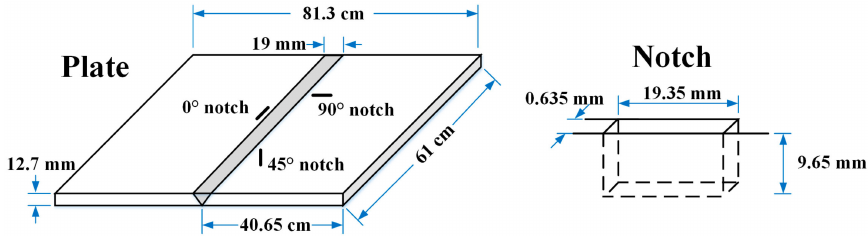
Figure 12. Plate and notch dimensions of a 12.7 mm thick 304 stainless steel welded plate having surface-breaking